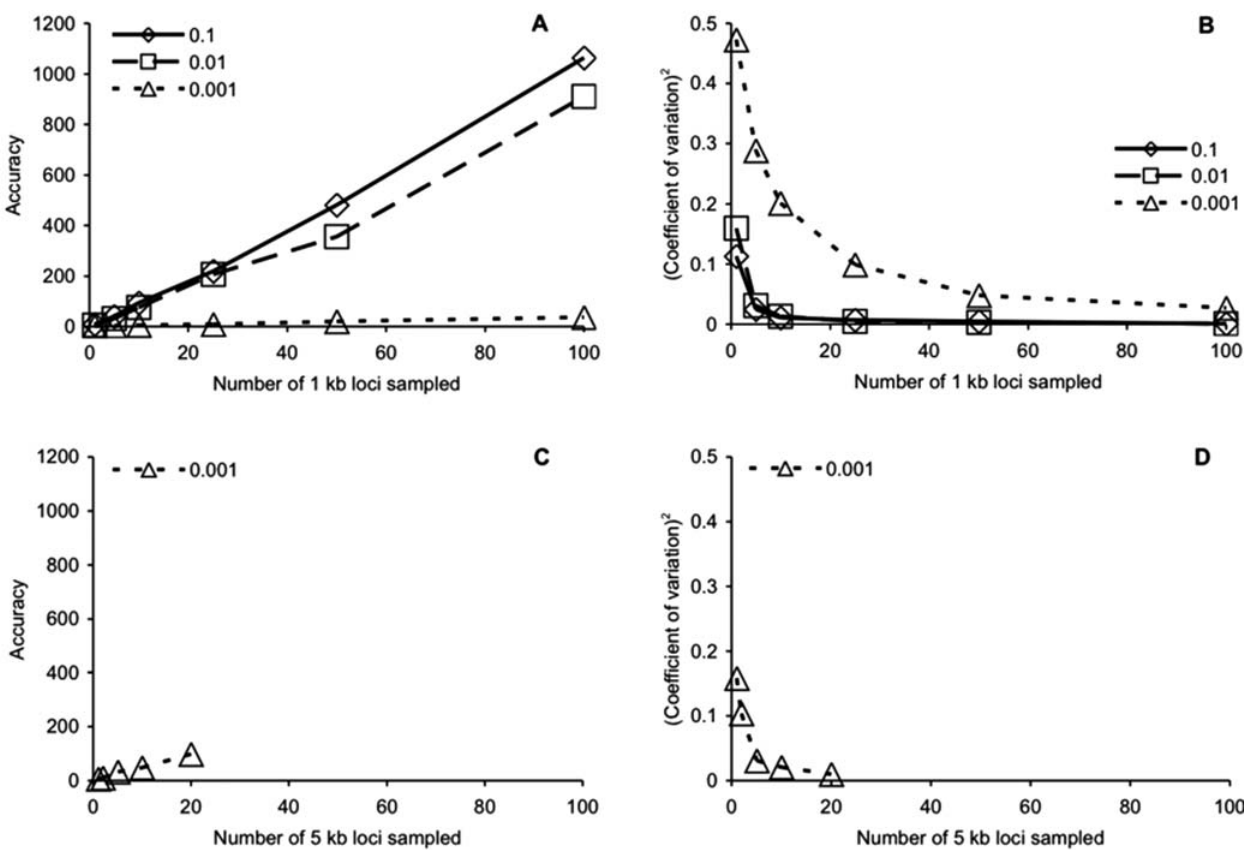
Figure 1. Influence of increasing the number of loci sampled per individual on the coalescent estimates of h (0.1, 0.01, 0.001): (A) improvement in accuracy (mean 2 /variance), loci sampled are 1 kb in length; (B) improvement in squared coefficient of variation ((standard deviation/mean) 2 ), loci sampled are 1 kb in length; (C) accuracy, loci sampled are 5 kb in length, h =0.001 (see text); (D) squared coefficient of variation, loci are 5 kb in length (see text).